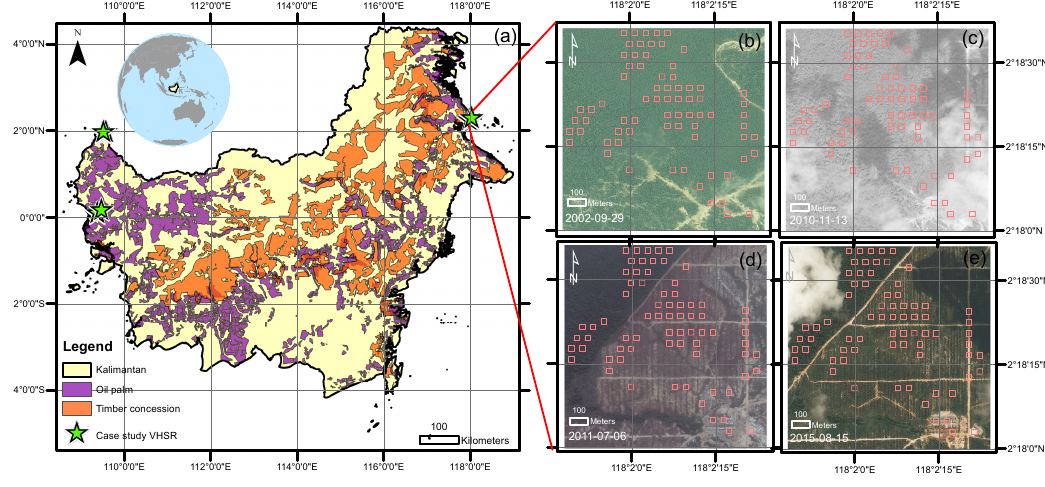
Figure 1. ( a ) Location of six case study area where multitemporal very high spatial resolution images (VHSR, green stars) were available. The geographic extent of the VHSR images is given in Table A1, Appendix A. The map of primary intact forest area in 2000 was obtained from [24] (class values 2, 4, 5, 6, 7, 8, 9 in the original map). The map of oil palm concessions [25] and logging concessions [26] were obtained from [27], made openly available by Global Forest Watch, and produced by the Indonesia Ministry of Environment and Forestry. VHSR images of one scene is shown in ( b – d ) (dates shown in lower left corner) overlain with interpreted reference Landsat sample pixels area (red squares). The VHSR images were obtained through Digital Globe viewing